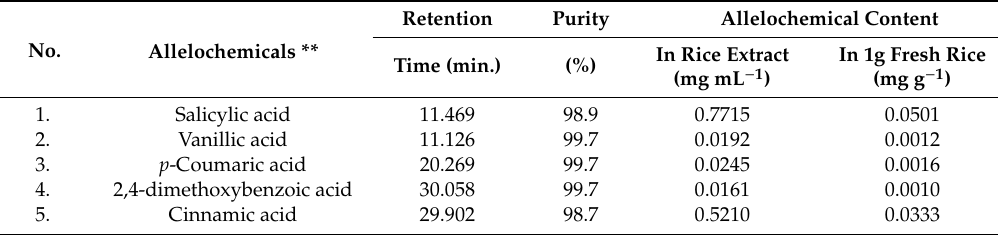
Table 6. Analysis results of allelochemicals in OM 5930 * rice cultivar by HPLC.